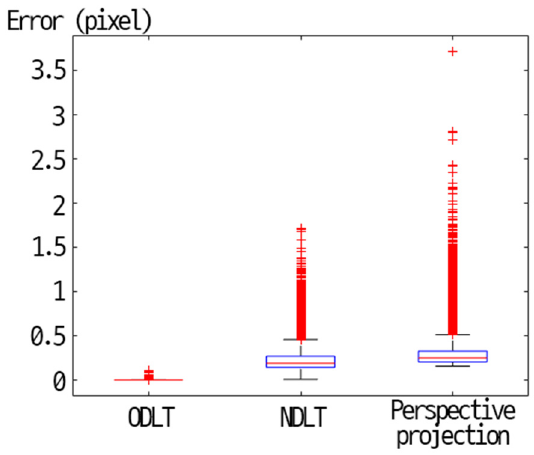
Figure 8. Box plots of mean reprojection error results.